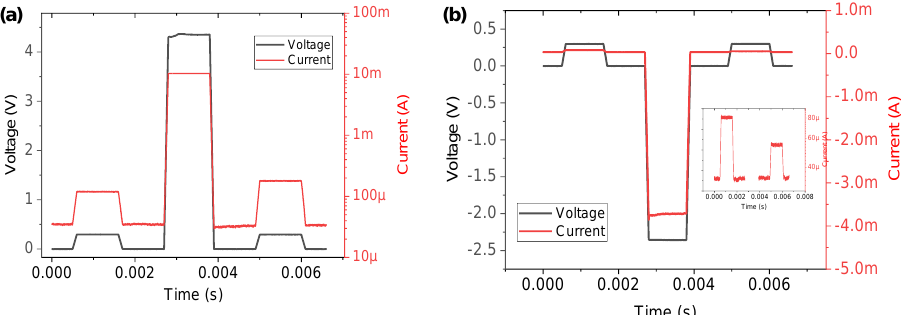
Figure 5. Pulse transient characteristics. ( a ) Set process and ( b ) reset process.